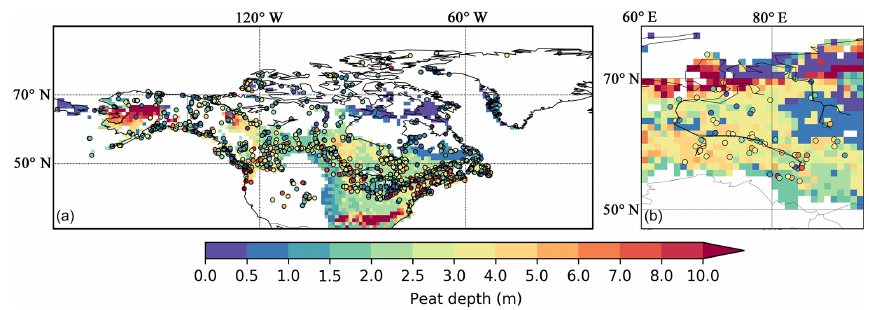
Figure 9. Measured (colour-filled circles, with colours indicating measured values) and simulated (background maps) peat depth in North America (a) and in the West Siberian lowlands (b) . Measured peat cores from North America are from Gorham et al. (2012), while those from the West Siberian lowlands are from Kremenetski et al. (2003).